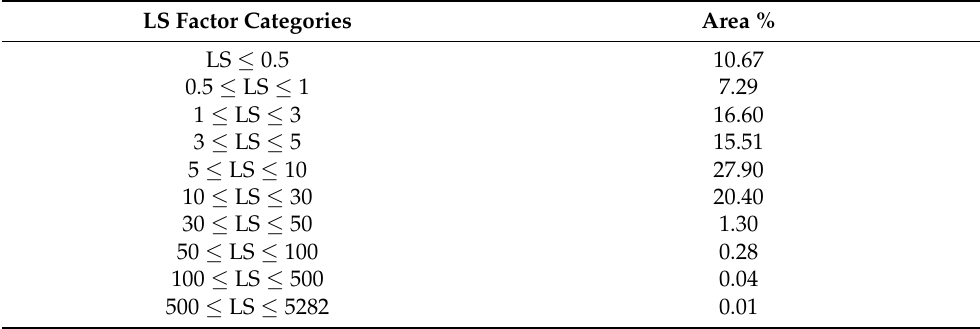
Table 4. Slope length and steepness (LS) factor categories and the corresponding percentage in terms of areal surface in Basilicata